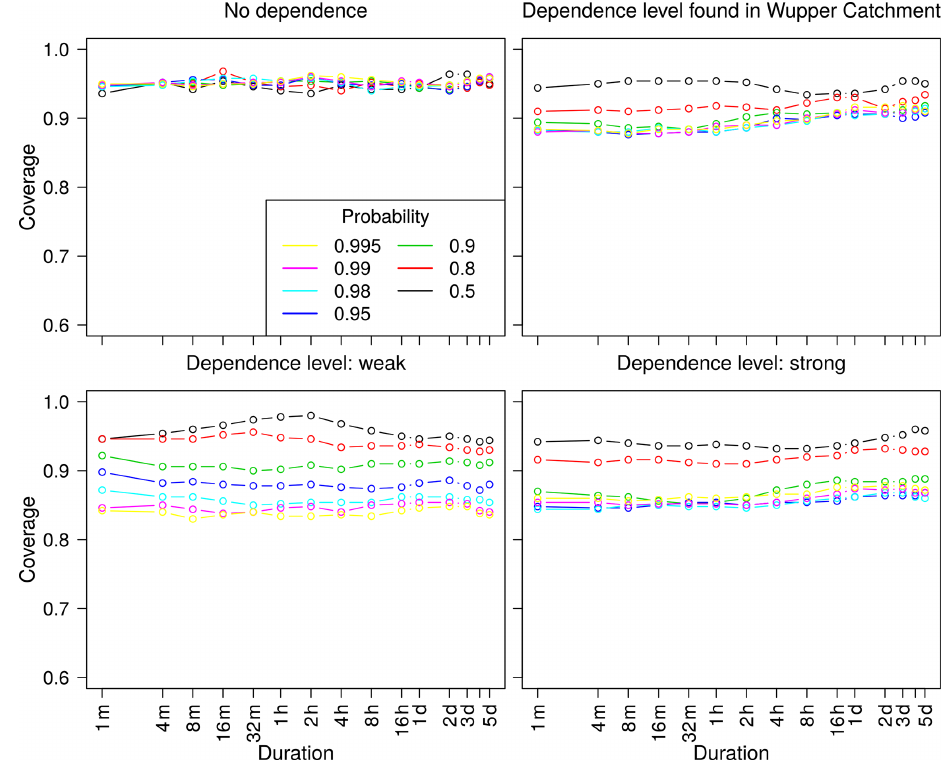
Figure 6. Bootstrapping coverage. Using a Brown–Resnick max-stable process, the coverage was determined in order to investigate the reliability of 95% confidence intervals from bootstrapping. A total of three different levels of dependence were